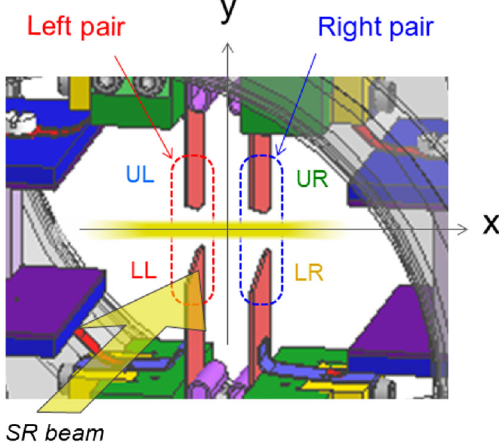
FIG. 26. Schematic diagram of a pair of left and right XBPMs for vertical